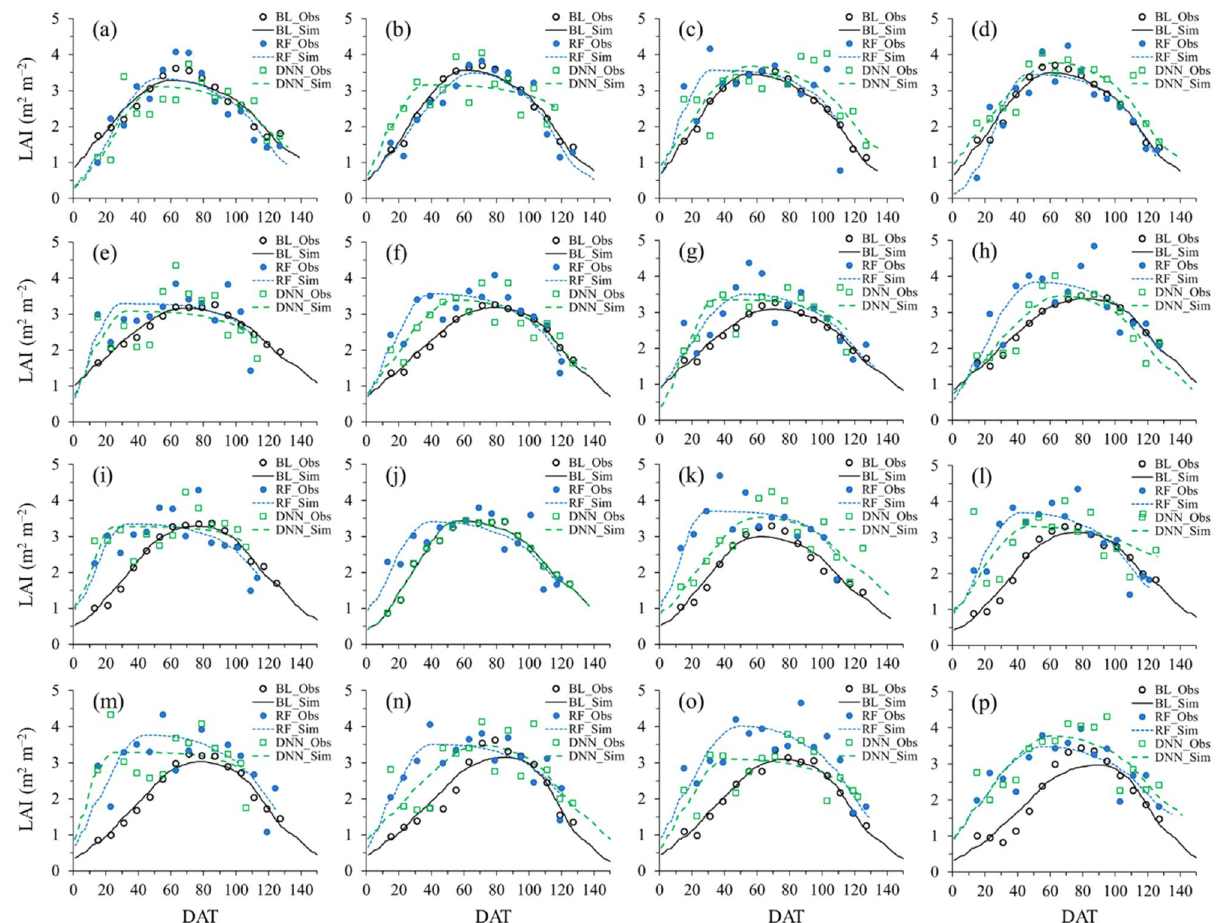
Figure 3. Simulated (Obs) versus observed (Obs) LAI of paddy rice for the datasets, obtained using the RF and DNN regressors in comparison with the baseline (BL) for ( a – d ) Cheorwon, ( e – h ) Paju, ( i – l ) Gimje, South Korea and ( m – p ) Pyeongyang, North Korea in ( a , e , i , and m ) 2014, ( b , f , j , and n ) 2015, ( c , g , k , and o ) 2016, and ( d , h , l , and p ) 2017. Sim LAI values were produced using a remote sensing-integrated crop model, while Obs LAI values of the BL were obtained from the MODIS